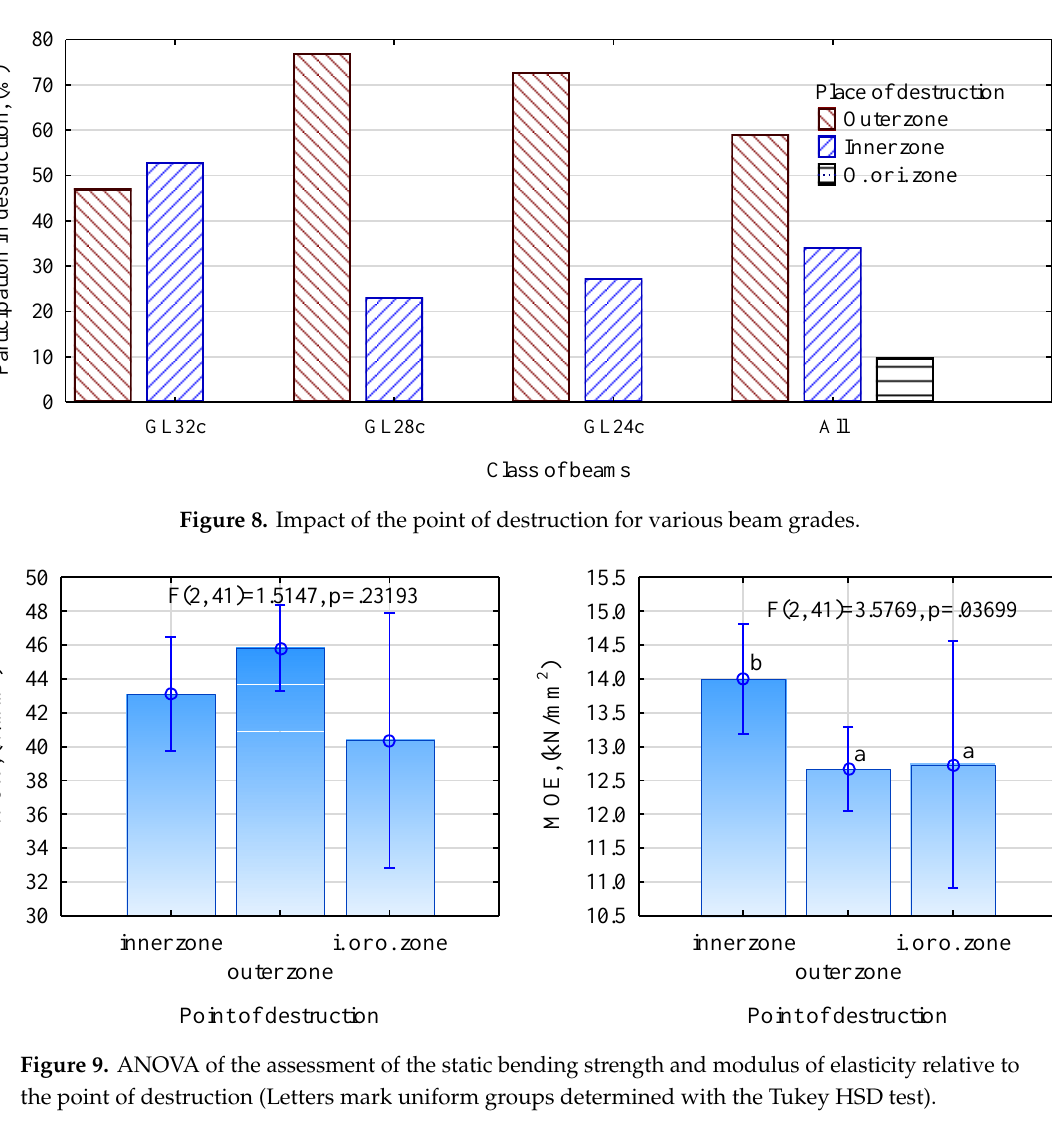
Figure 7. Beam failure images: ( a ) GL24c—MOR(MOR 12% )—48.5(43.4) N/mm 2 —the strongest in the group, ( b ) GL28c—MOR(MOR 12% )—30.4(25.8) N/mm 2 —the weakest in the group.